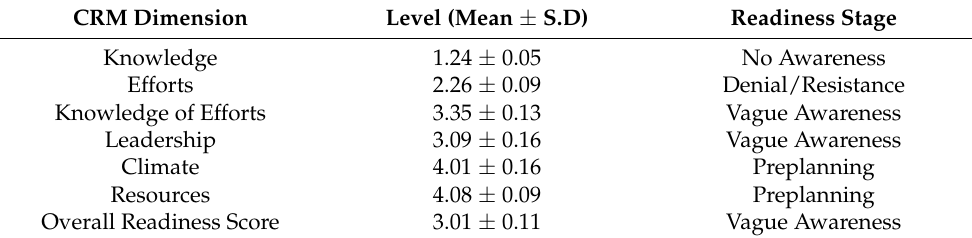
Table 2. Community readiness level in 6 dimensions (N = 999).